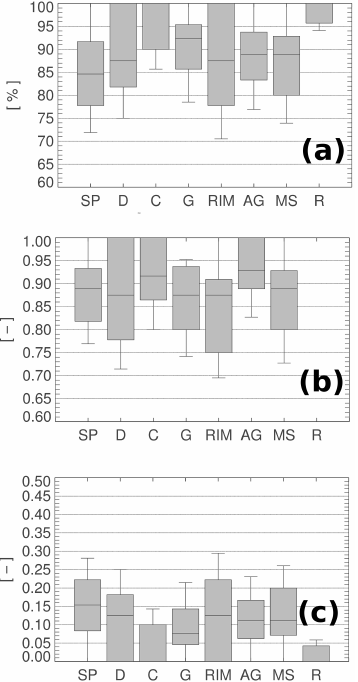
Figure 7. Bar plots of (a) OA k [%], (b) POD k [–], (c) POFD k asso- ciated with the eight hydrometeor classes undergoing classification. Statistics were calculated over 200 realizations of the SVM valida- tion.